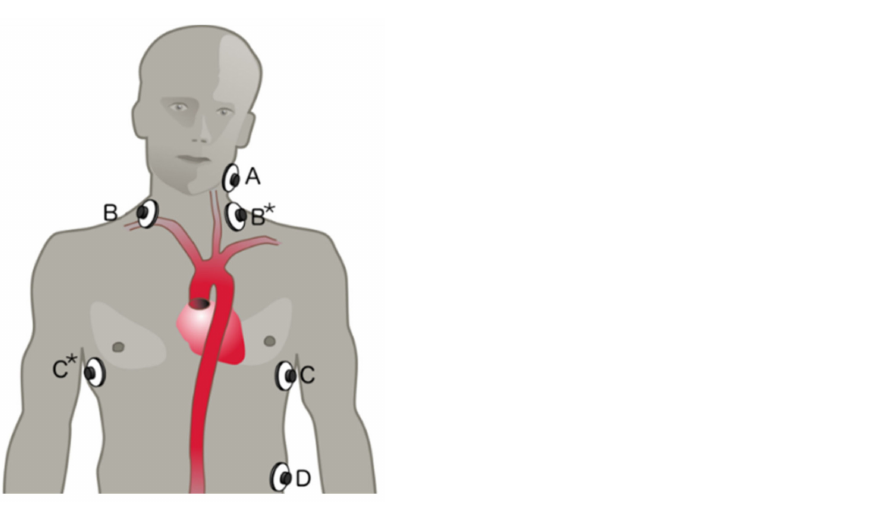
Figure 7. Front view of a subject with electrode positions—electrode A and D inject the current, electrode B/B* and C/C* are used to measure the surface